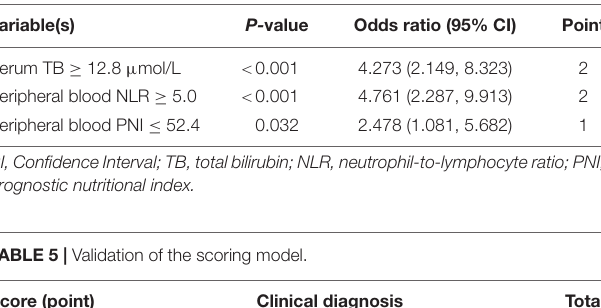
TABLE 4 | Coefficients of binary logistic regression in training set.